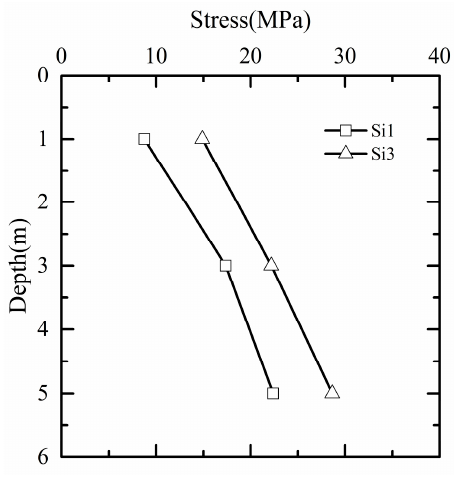
Figure 10. Measured stable structure stress.